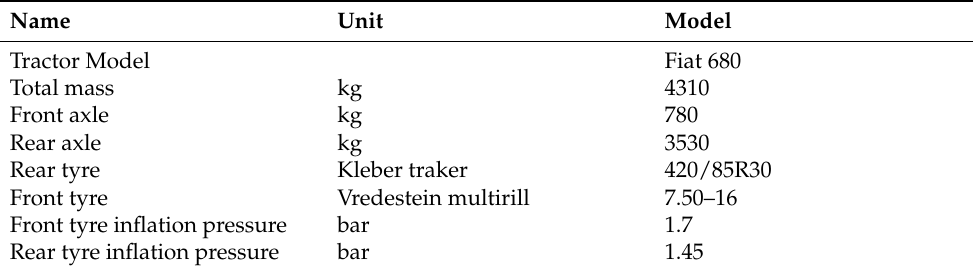
Table 1. Technical data of the tractor used in the experiment.